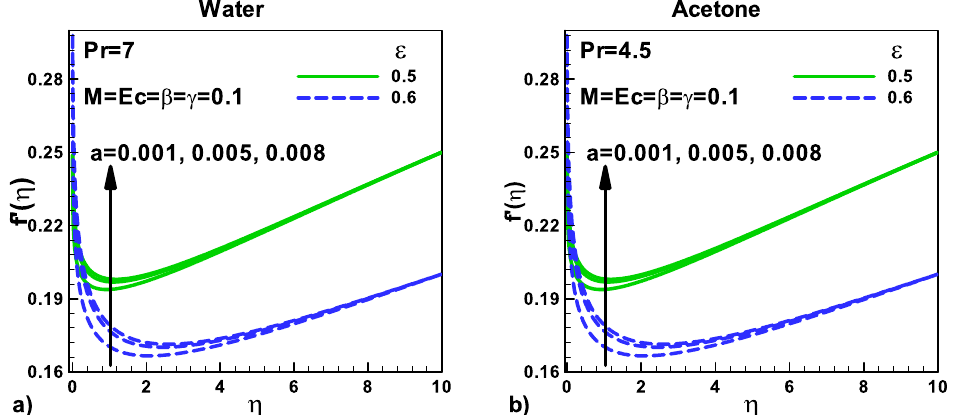
Figure 2. Effects of velocity ratio parameter on dimensionless velocity at different positions for ( a ) water ( b )